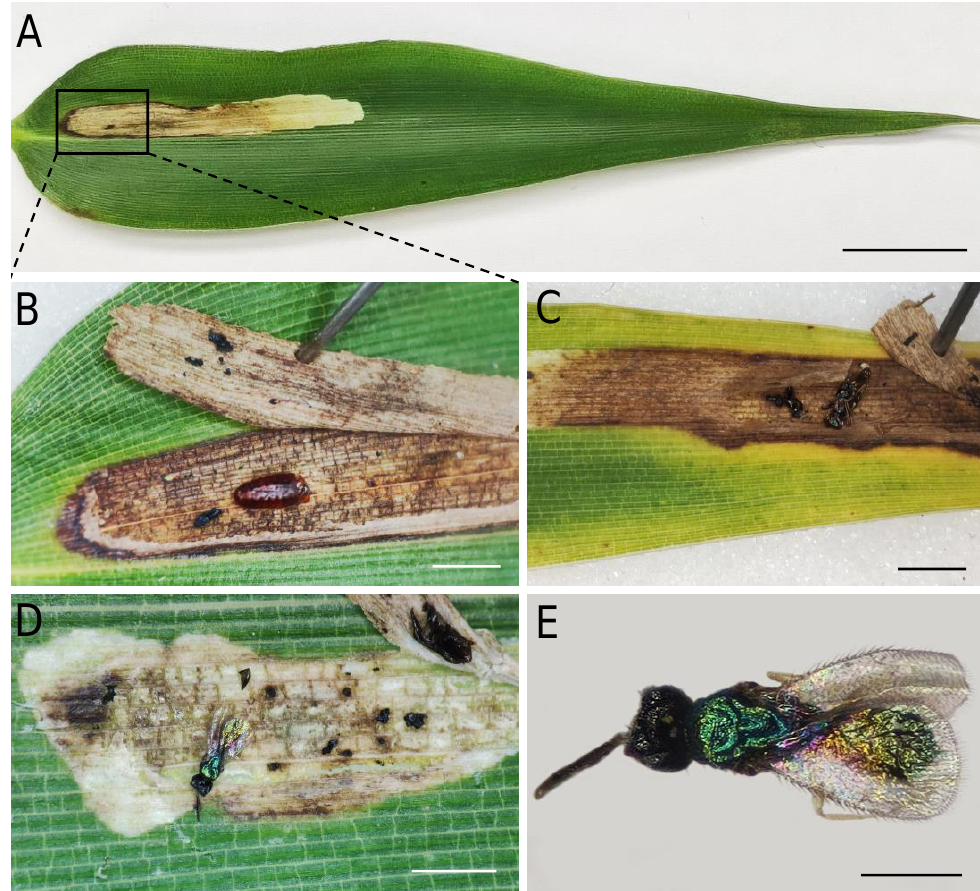
Figure 6. The mines of Cerodontha unisetiorbita on Phyllostachys viridiglaucescens found in the Volčji Potok Arboretum, Slovenia, 9. August 2022. ( A , B ) a mine with a dead puparium; ( C – E ) a mine with an adult parasitoid Chrysocharis sp. (Hymenoptera: Eulophidae) emerged from pupa of C. unisetiorbita. Scale: ( A ) 10 mm, ( B – D ) 2 mm, ( E ) 0.7 mm. Photo: N.I. Kirichenko, S. Gomboc.